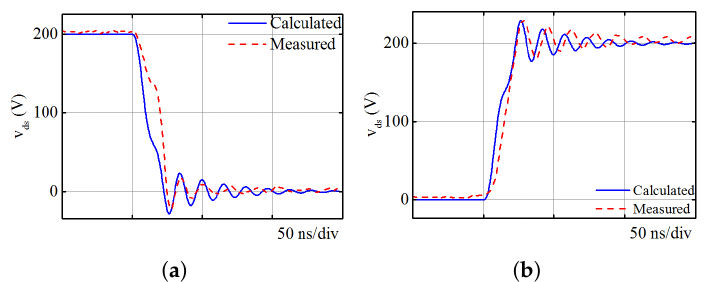
Figure 9. Calculated and measured waveforms of v ds during switching transient: ( a ) turn-on, ( b ) turn-off.